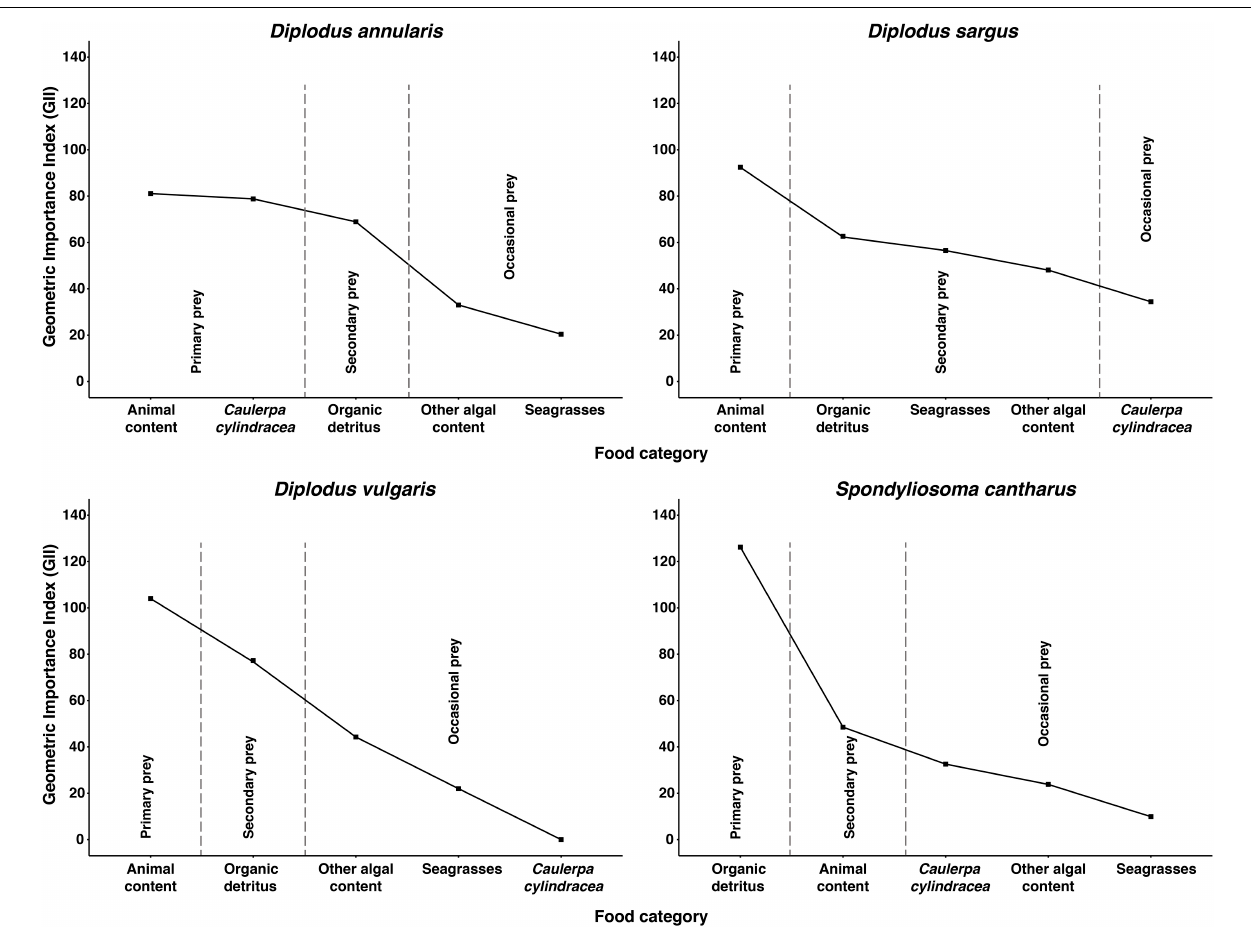
FIGURE 2 | Geometric Importance Index (GII) for each fish species. Food items are classified as: “Primary prey,” “Secondary prey,” or “Occasional prey” according to their relative importance to the diet of each fish species. The line connecting the points was added to help interpretation of the figure.